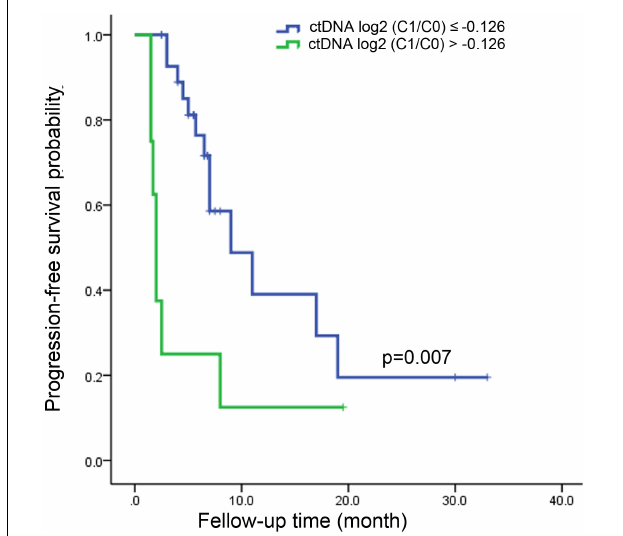
FIGURE 4 | Kaplan-Meier estimate for progression-free survival in metastatic colorectal cancer patients with ctDNA log2 (C1/C0) ≤ –0.126 and ctDNA log2 (C1/C0) > –0.126 after the first cycle of